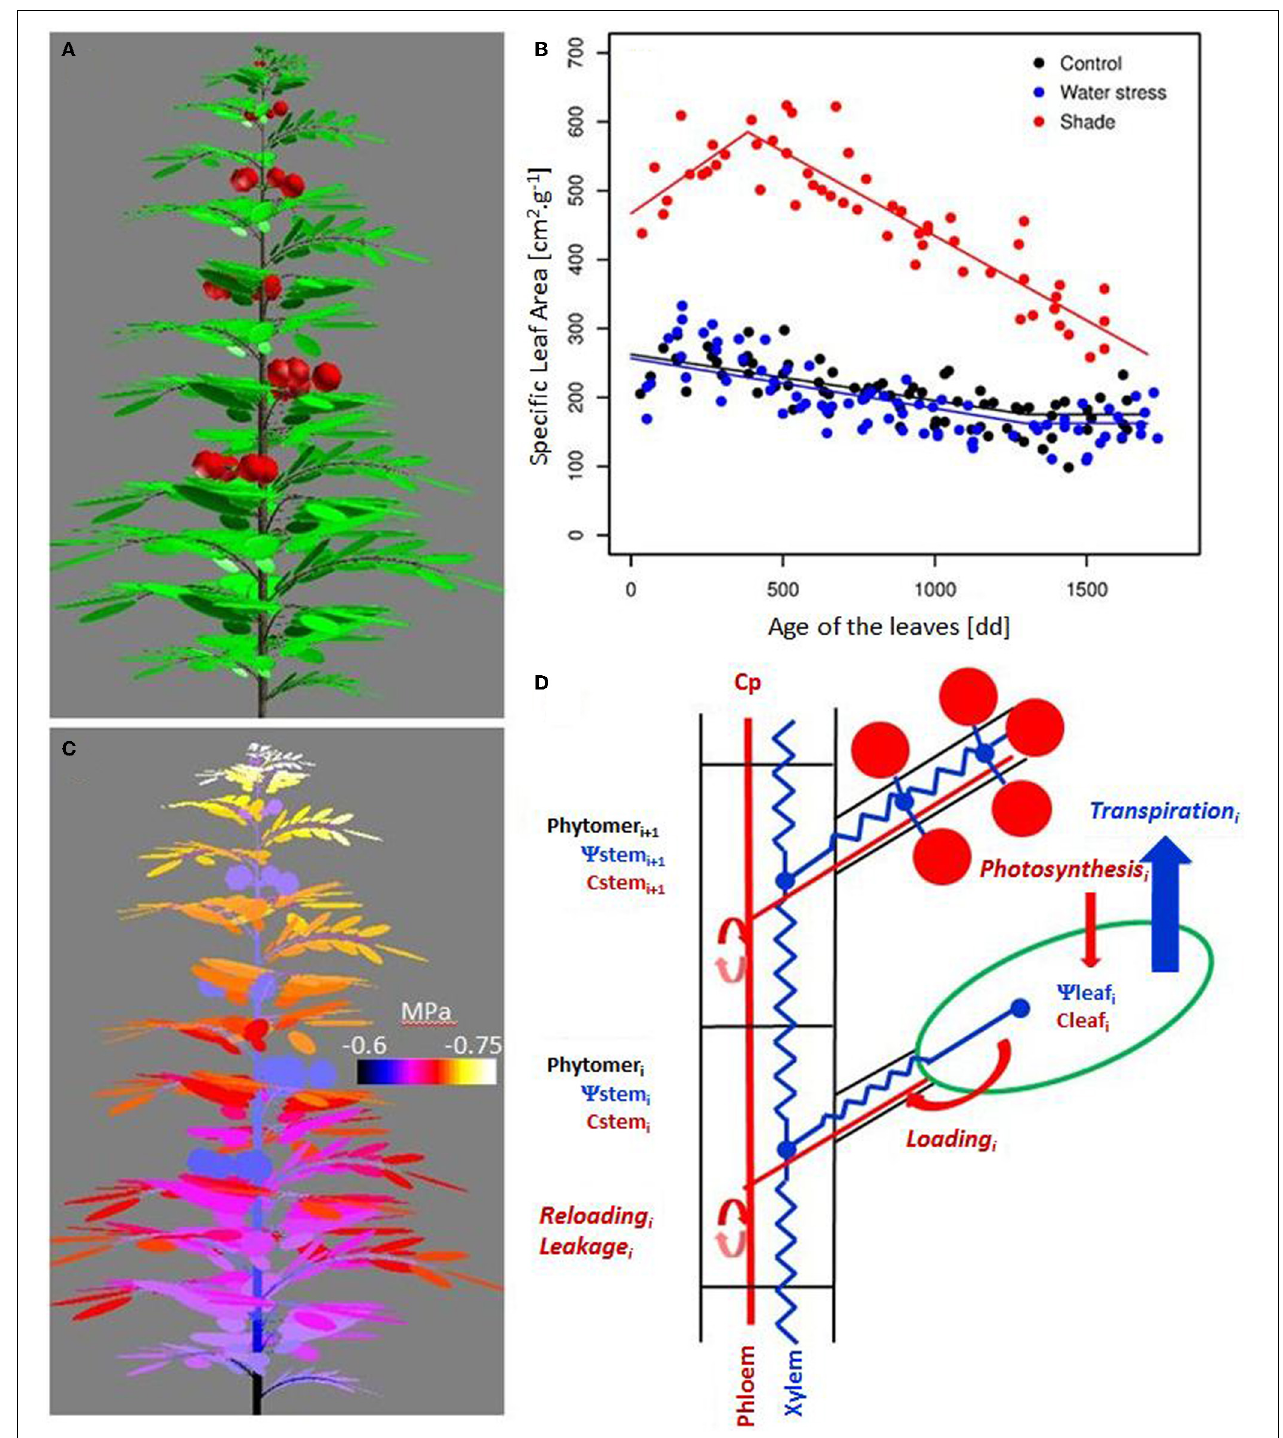
FIGURE 1 | Simulated architecture of a tomato plant (100 days old) using the dynamic 3D plant model (A), variation of the minimal water potential within the plant (C), variation of the Specific Leaf Area (SLA) with leaf age for the treatments (B), and schematic representation of the resource acquisition modeling and their transfer to the plant (D). Leaves are composed of different leaflets, which have similar incident radiation,